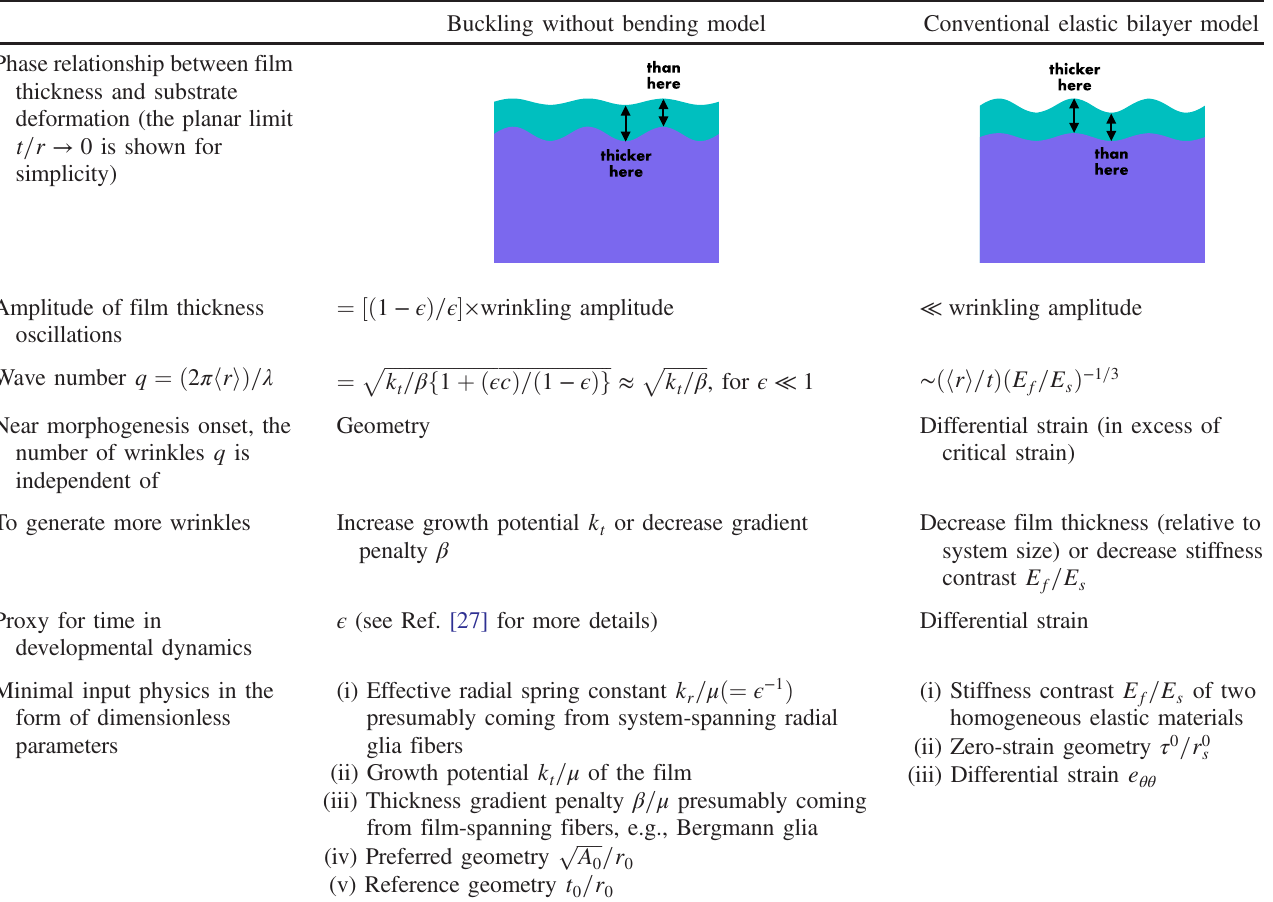
TABLE I. Summary of main predictions for the growth regime ( 0 < ϵ < 1 ) of the convex variant, with comparison to the corresponding predictions of a standard morphogenesis model. The ϵ ≪ 1 limit pertains to early development, i.e., just after the onset of shape change. The five dimensionless model parameters discussed above are written in a slightly different (but equivalent) form here in order to emphasize their physical